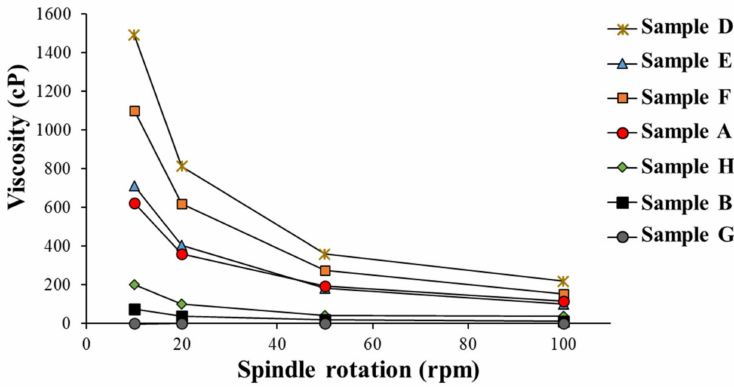
Figure 7. Viscosity of the coating solutions at 10, 20, 50 and 100 rpm.